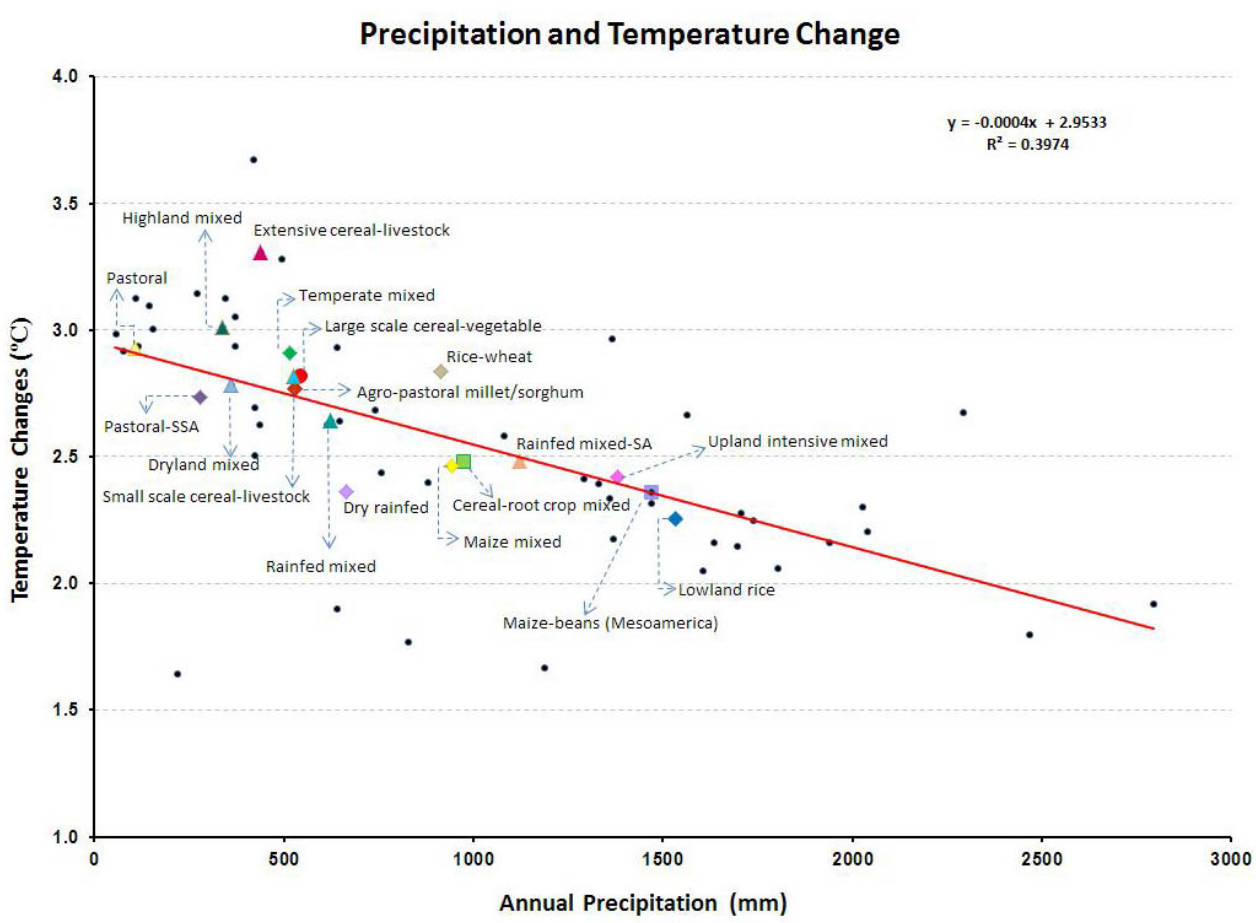
Figure 3. Average annual rainfall and average temperature change projected between the current temperature and 2050 temperature. Priority dryland cereal and legume farming systems are